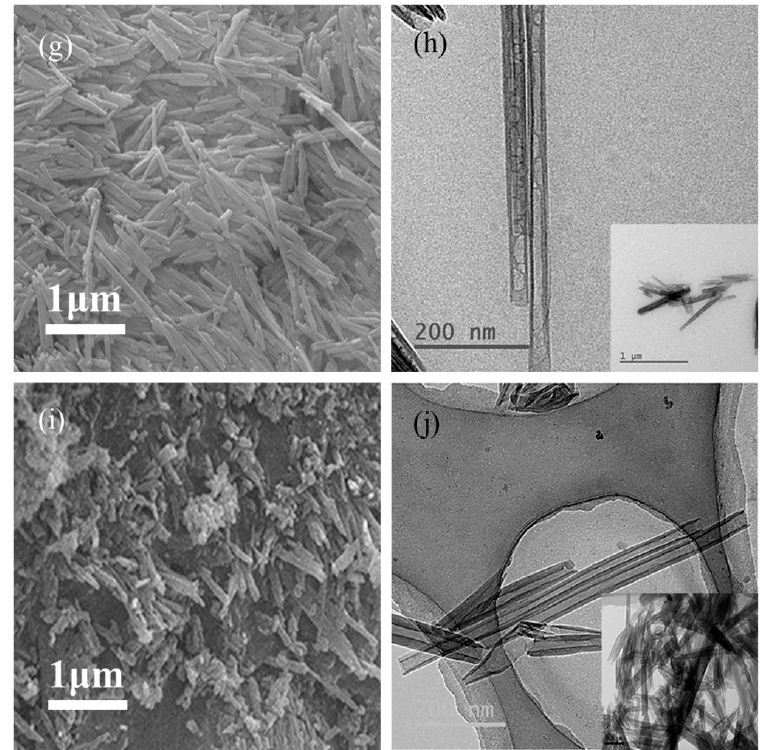
Figure 3. SEM and TEM images of ( a , b ) Hal-TL, ( c , d ) Hal-SY ( e , f ) Hal-AU ( g , h ) Hal-LF ( i , j ) Hal-CX. Table 3. Morphological characteristics of halloysites in this